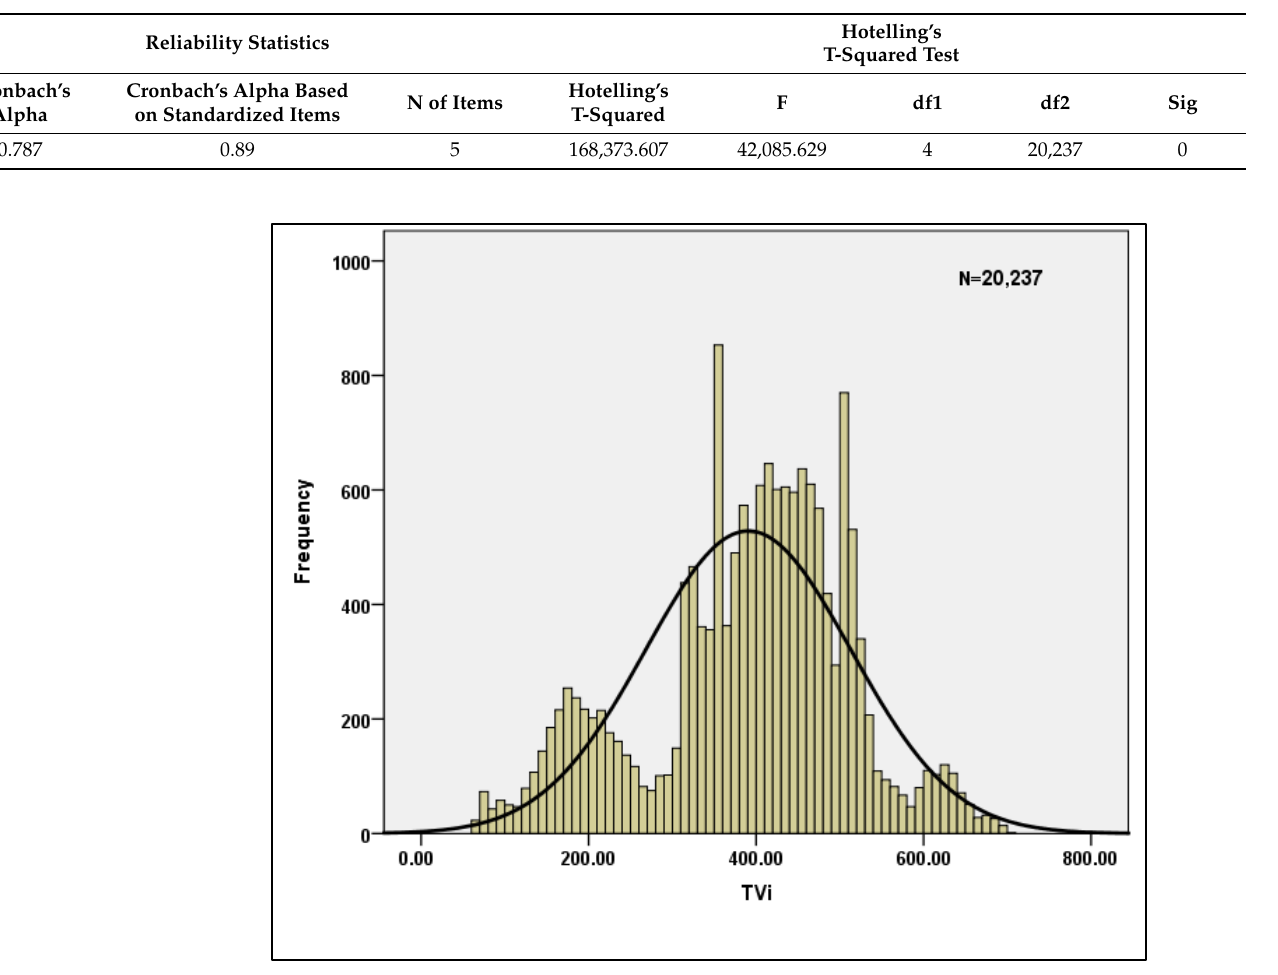
Figure 5. Normality plot for TVe. Table 3. Descriptive statistics of data. N